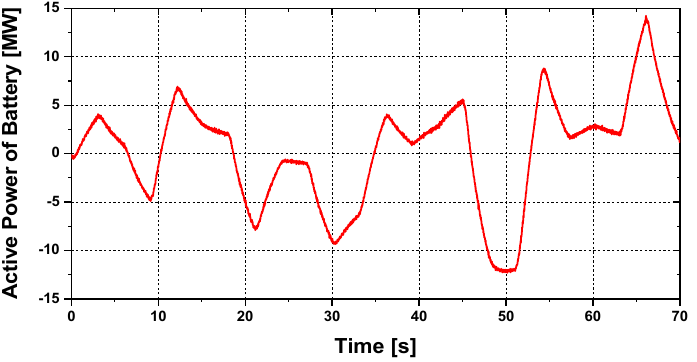
Figure 18. Real power response of FSWT-SCIG.